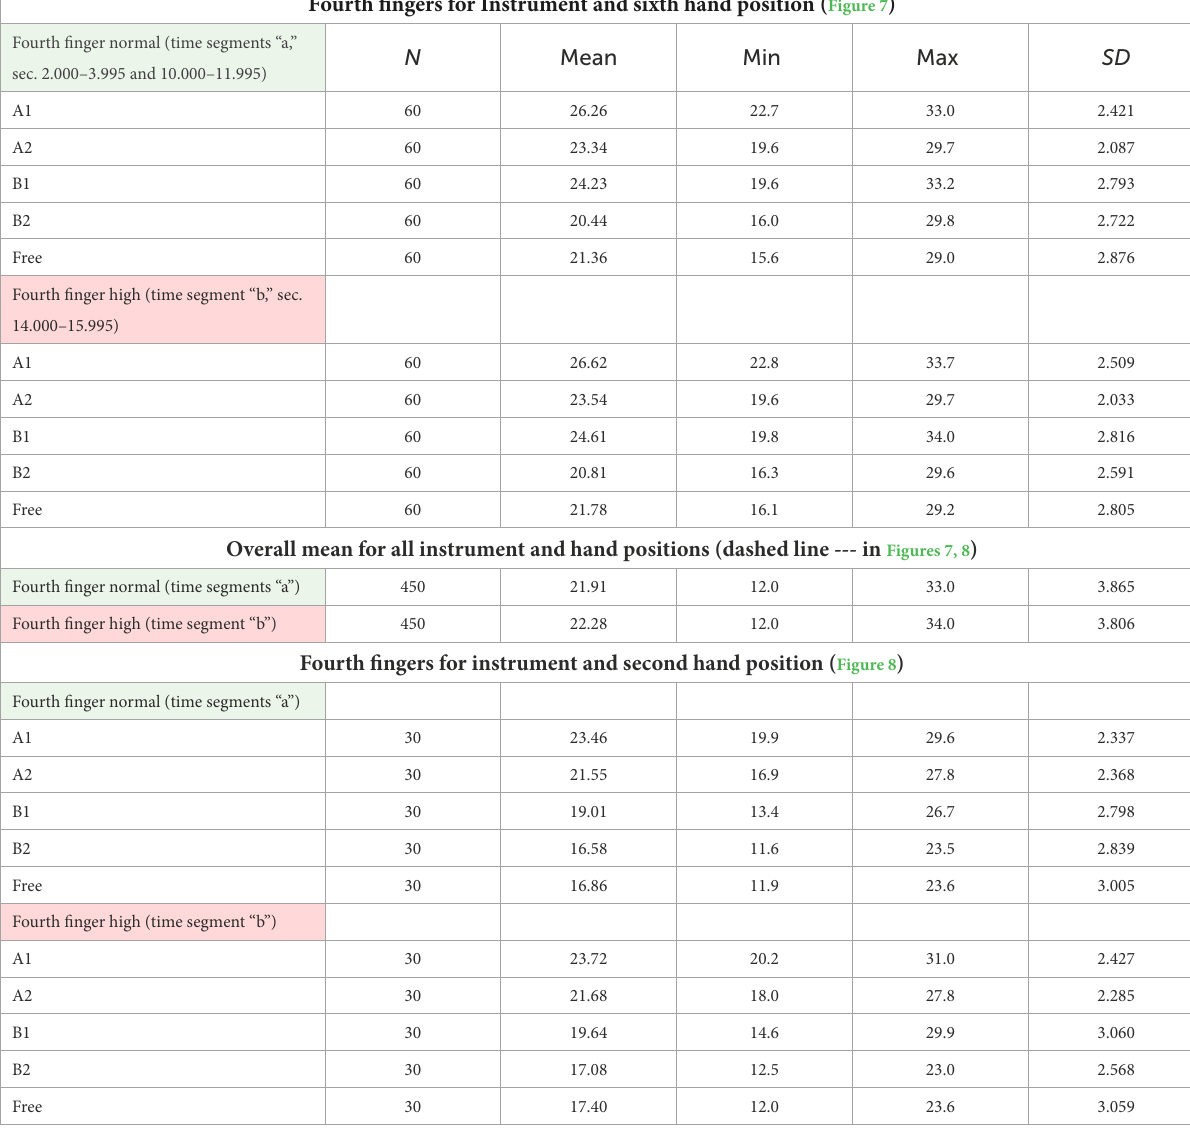
TABLE 6 Descriptive statistics for Reference Angle α (elbow/upper arm) compensation movement for the specific time segments when the fourth fingers are played. Fourth fingers for Instrument and sixth hand position ( Figure 7 ) Fourth finger normal (time segments